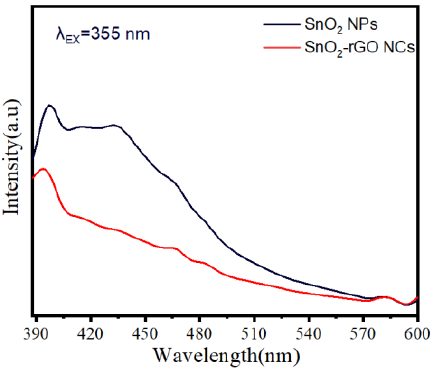
Figure 9. PL spectra of the SnO 2 NPs and SnO 2 -rGO